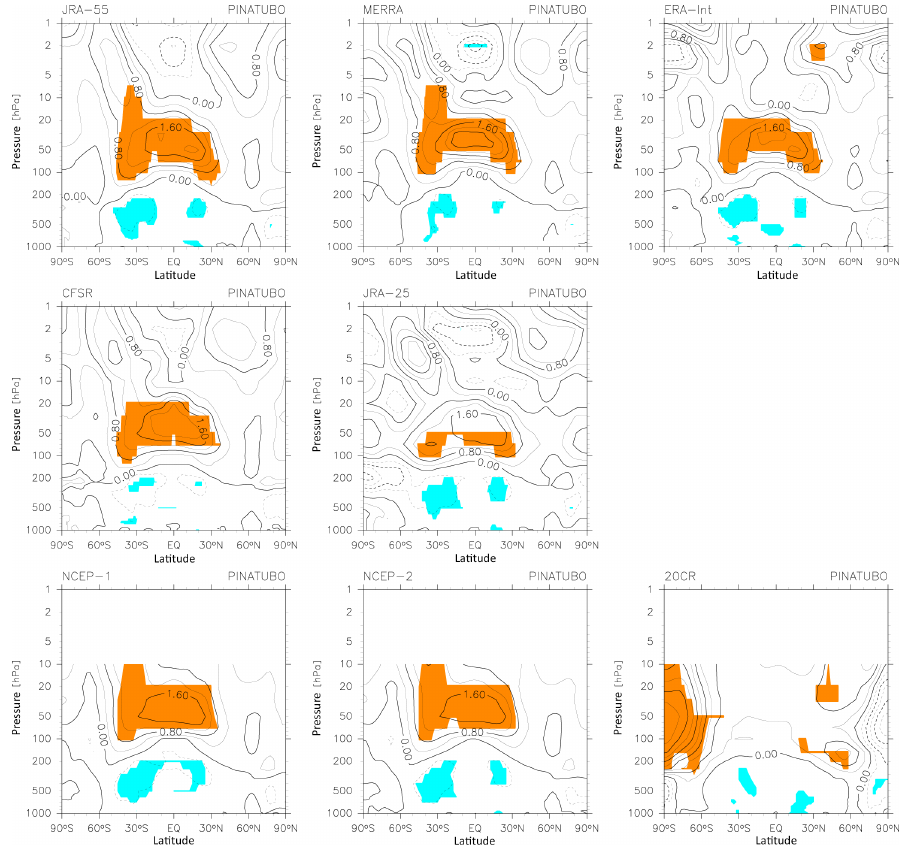
Figure 5. As in Fig. 4 but for the Mount Pinatubo eruption in June